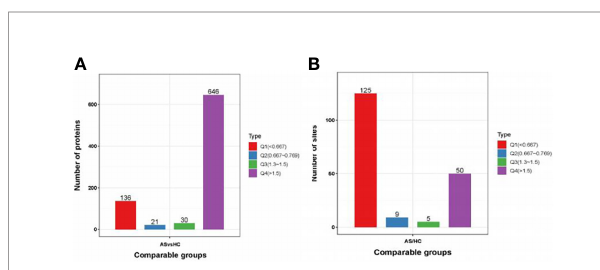
FIGURE 1 | Protein identi fi cation. (A, B) DEPs and DPPs between AS patients and healthy controls. DEPs, differentially expressed proteins; DPPs, differentially Phosphorylated